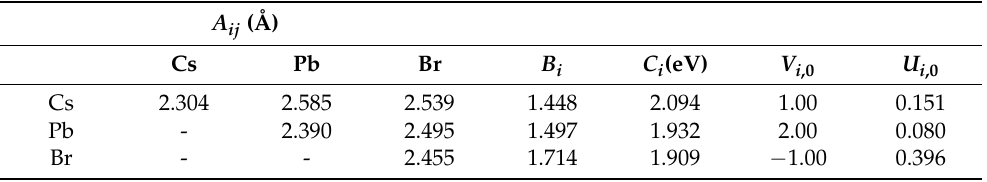
Table 1. BV model potential parameters of CsPbBr 3